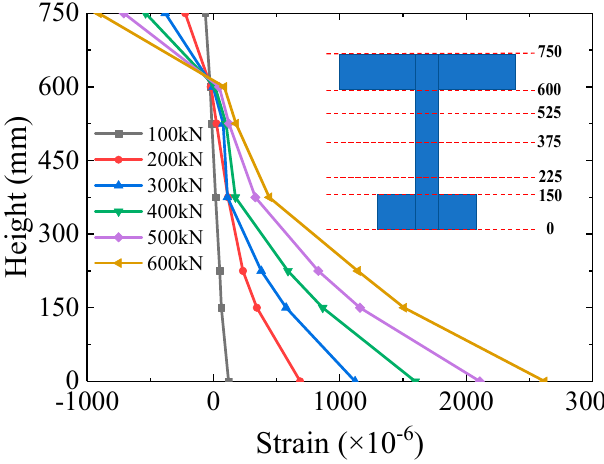
Figure 12. Distribution of sectional strain at mid-span. As shown in Figure 6c, the steel top flange was divided into four cells by longitudinal stiffeners, and in the mid-span section, strain gauges were deployed both in the support and in the center part of these cells. Figure 13 shows the strain versus loading at the cell supports and cell central part. It can be inferred that the strain profile across the top steel flange is uniform up to 400 kN. As the load kept increasing, the strain at the different locations tends to diverge due to minor local buckling. Generally, the stiffening rib determined the position of the local buckling but did not have a significant impact on the strain variation during the